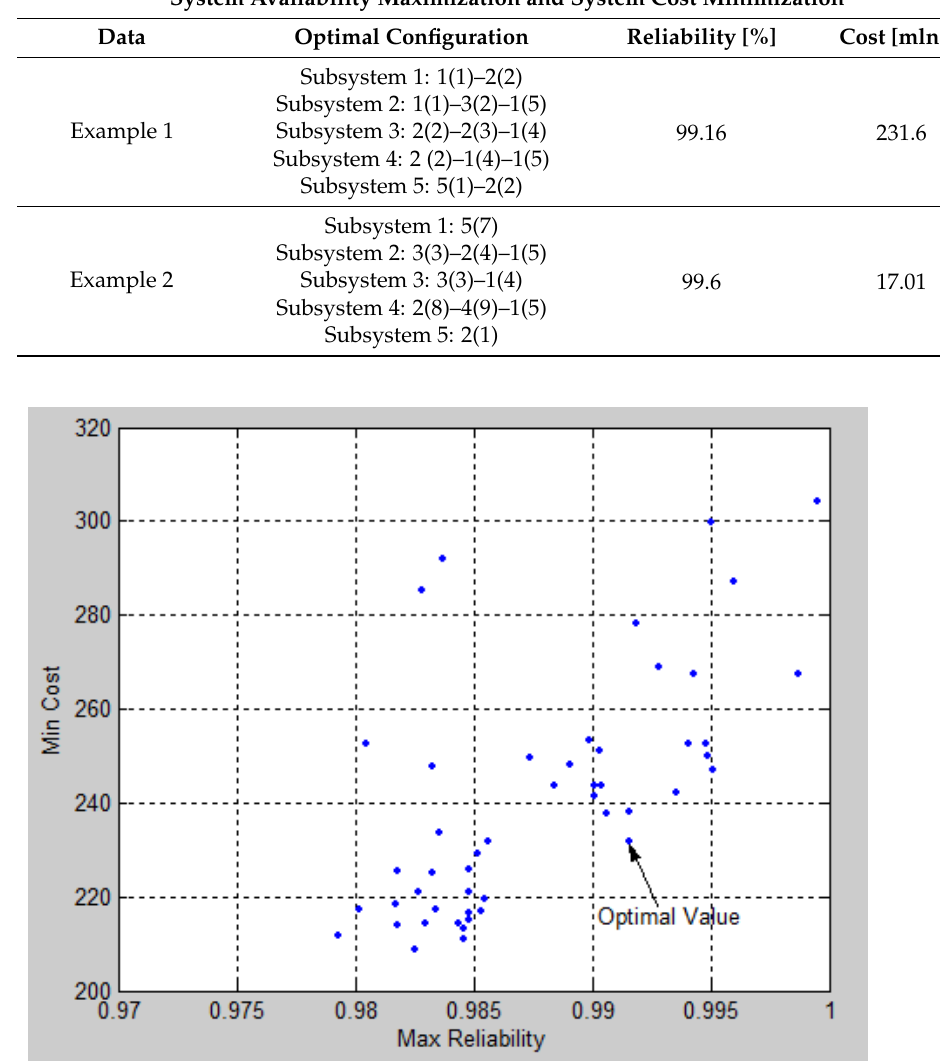
Figure 3. Pareto front of Example 1.